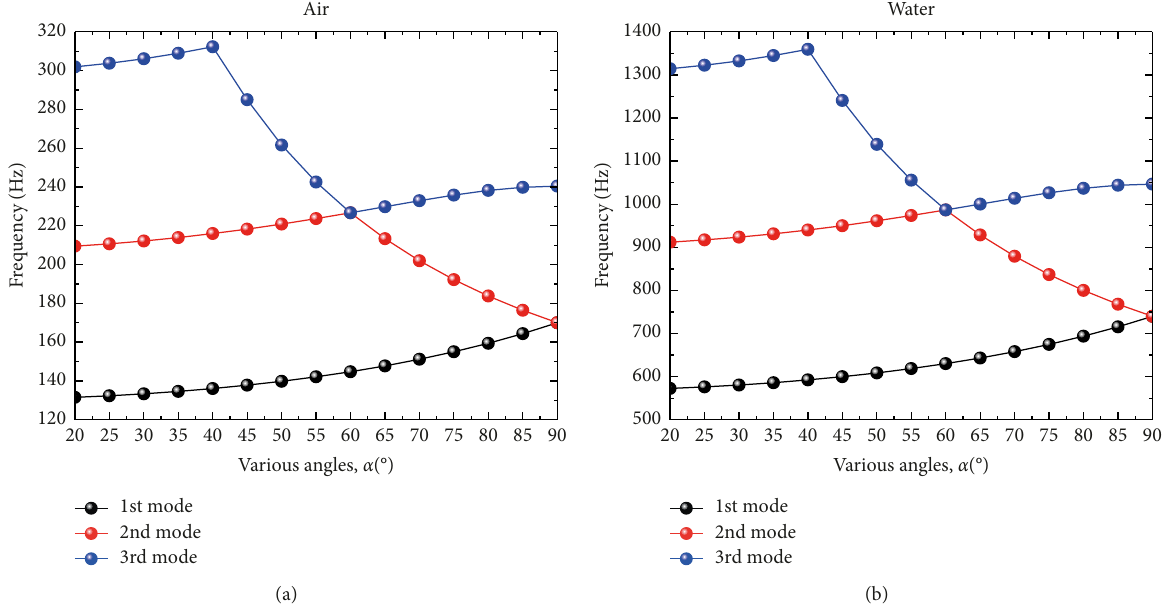
Figure 6: Variation of the frequency of the quadrangular prism acoustic cavity with various apex